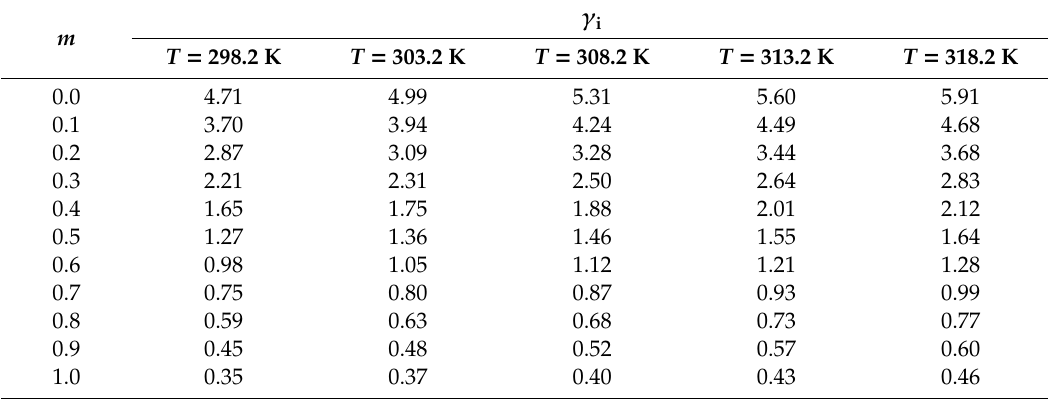
Table 3. Activity coe ffi cients ( γ i ) of ECT in various “PEG-400 + water” mixtures ( m ) at “ T = 298.2 to 318.2 K”.